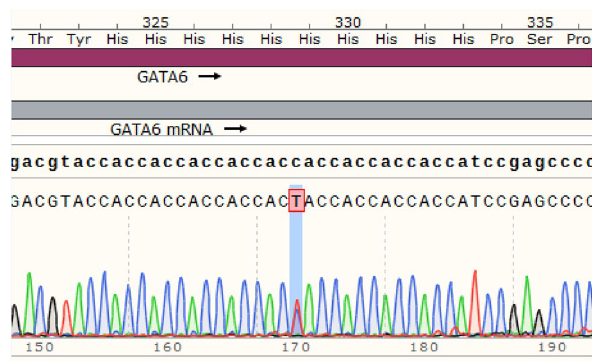
Figure 2. DNA sequence of a segment flanking H329Y in GATA6 gene from an affected member. Histidine converts to Tyrosine following a single base substitution; the substitution of a Histidine by Tyrosine takes place at position 329. Red highlight denotes a heterozygote C > T nucleotide